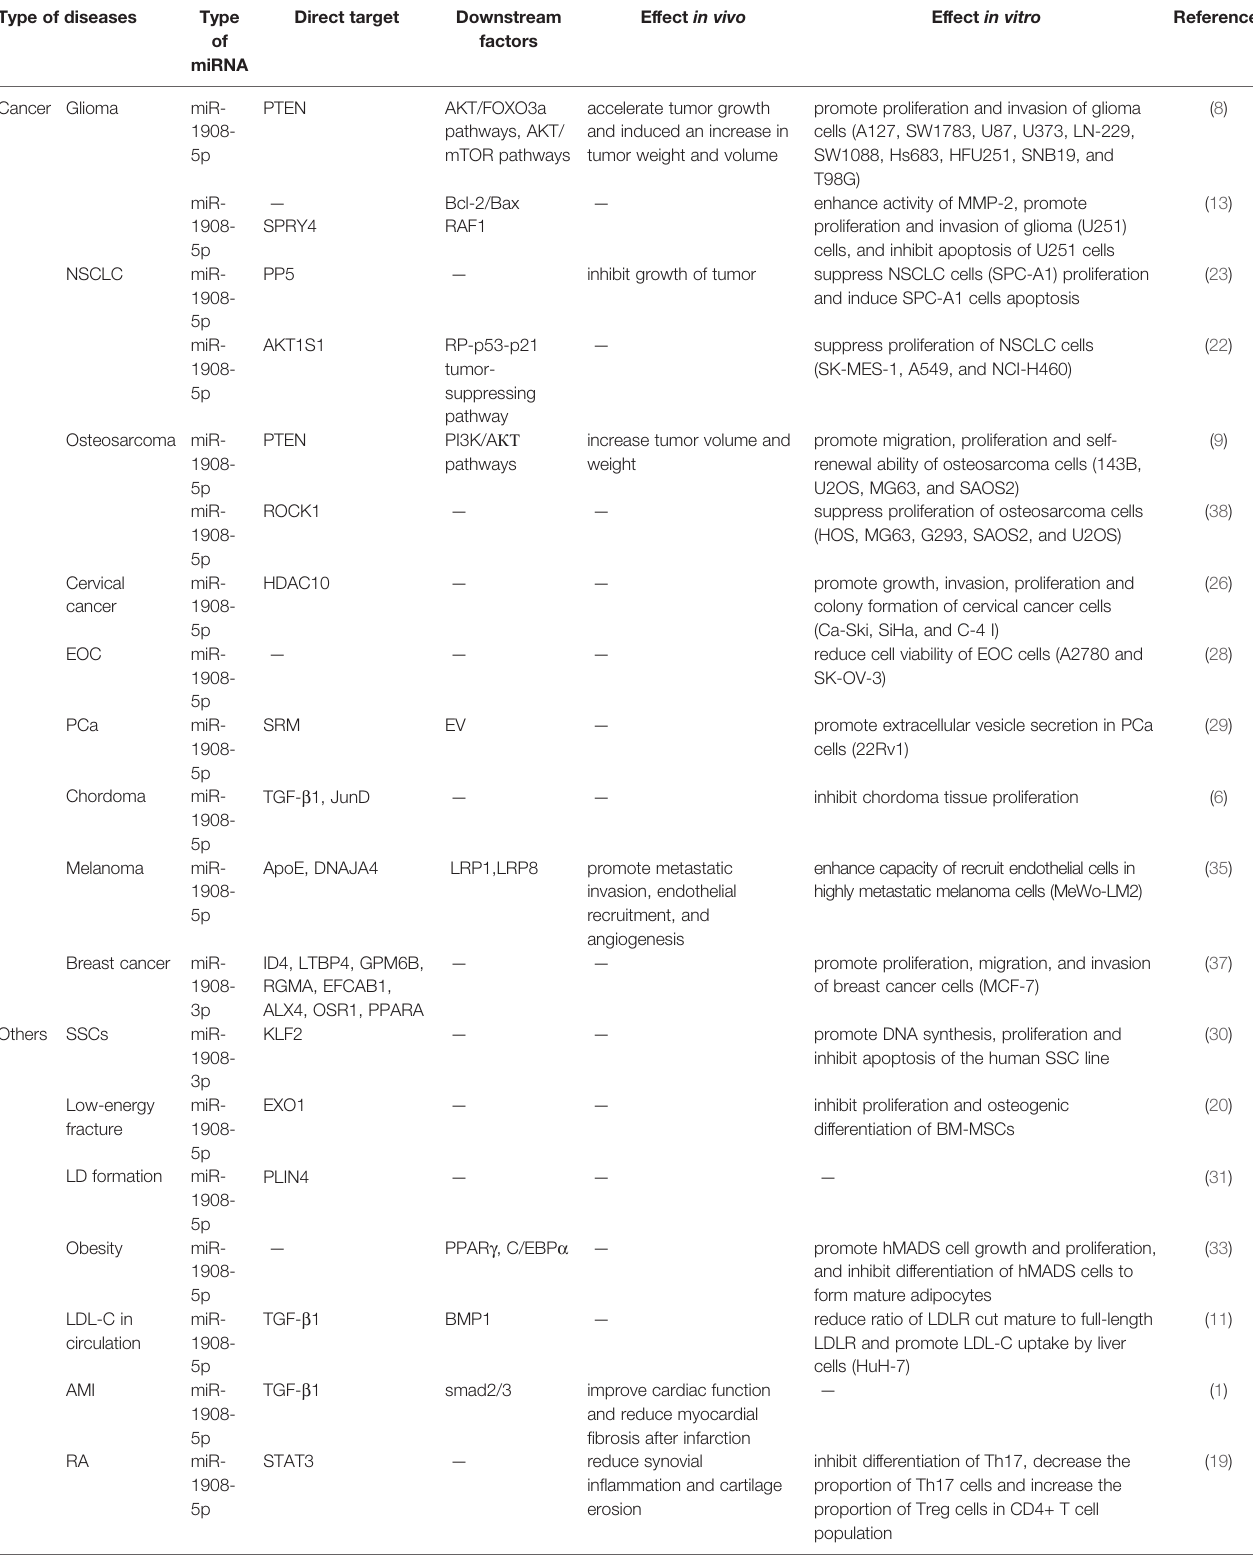
TABLE 2 | Direct target and downstream factors of miR-1908 and the regulation effects in vivo and in vitro in various